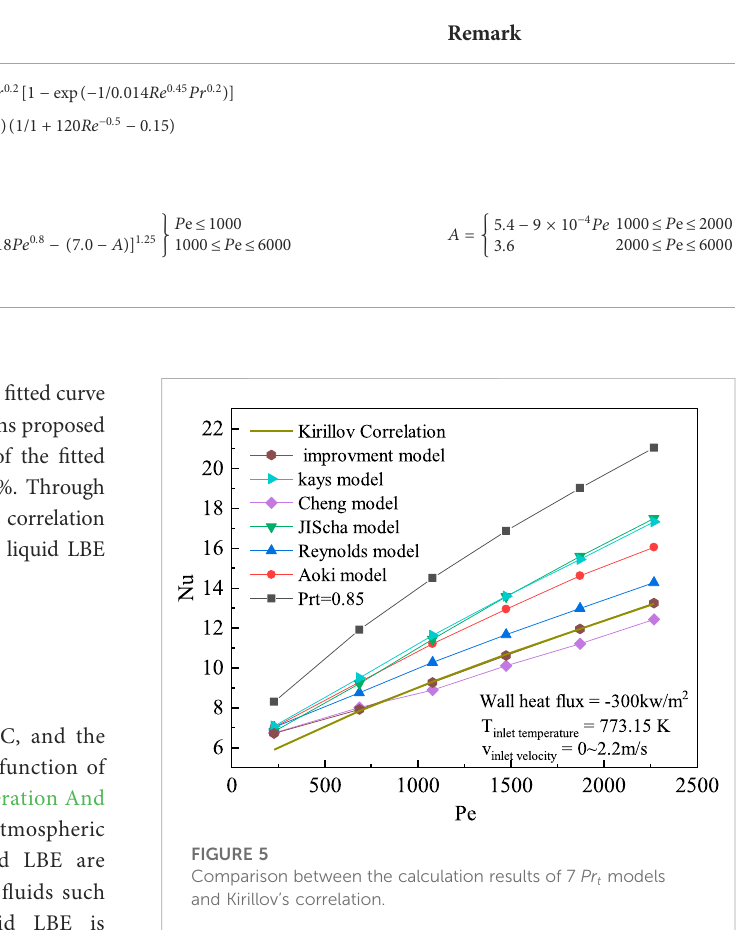
TABLE 4 Turbulent Prandtl number models of liquid metals.